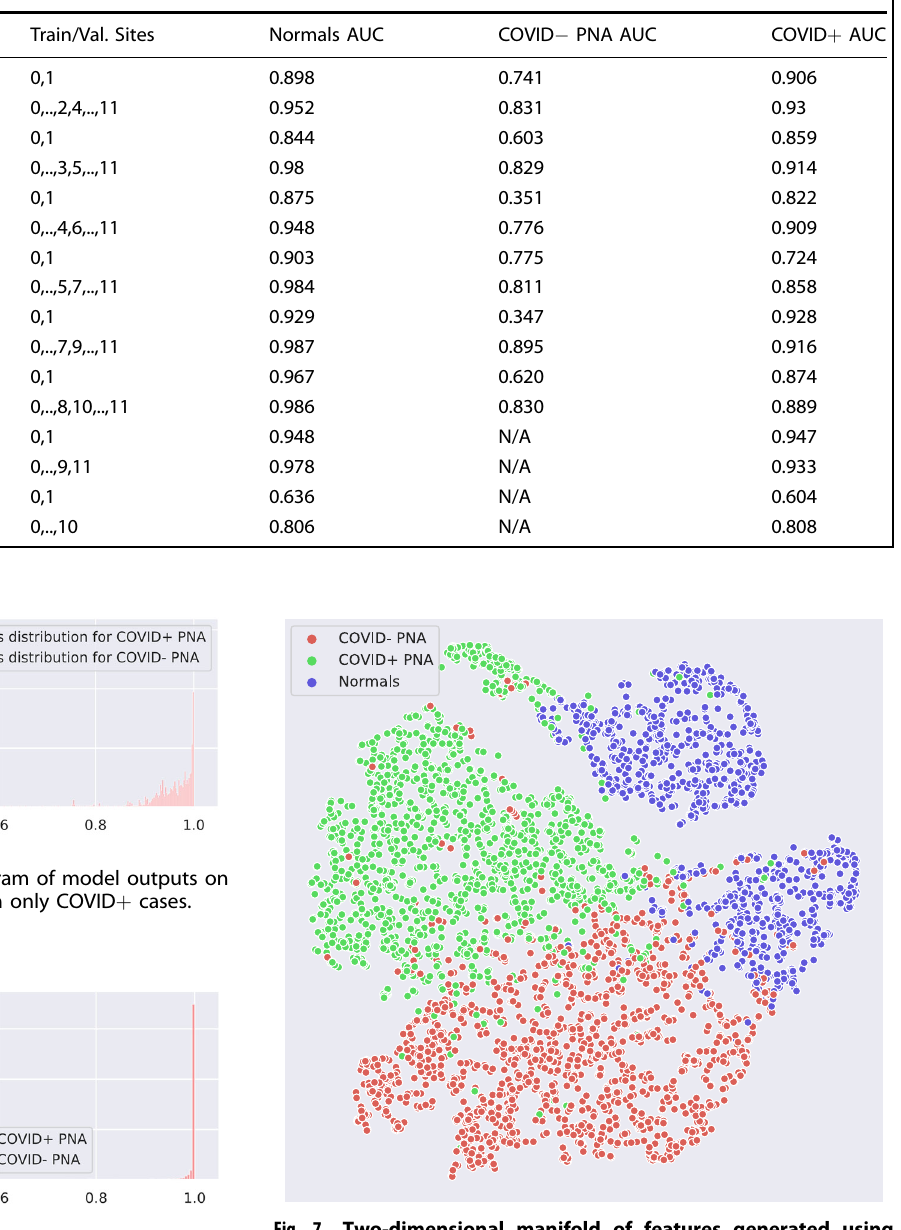
Fig. 5 DCD predictions for Site 12. Histogram of model outputs on external hold-out test site 12 (GUMS) with only COVID + cases.